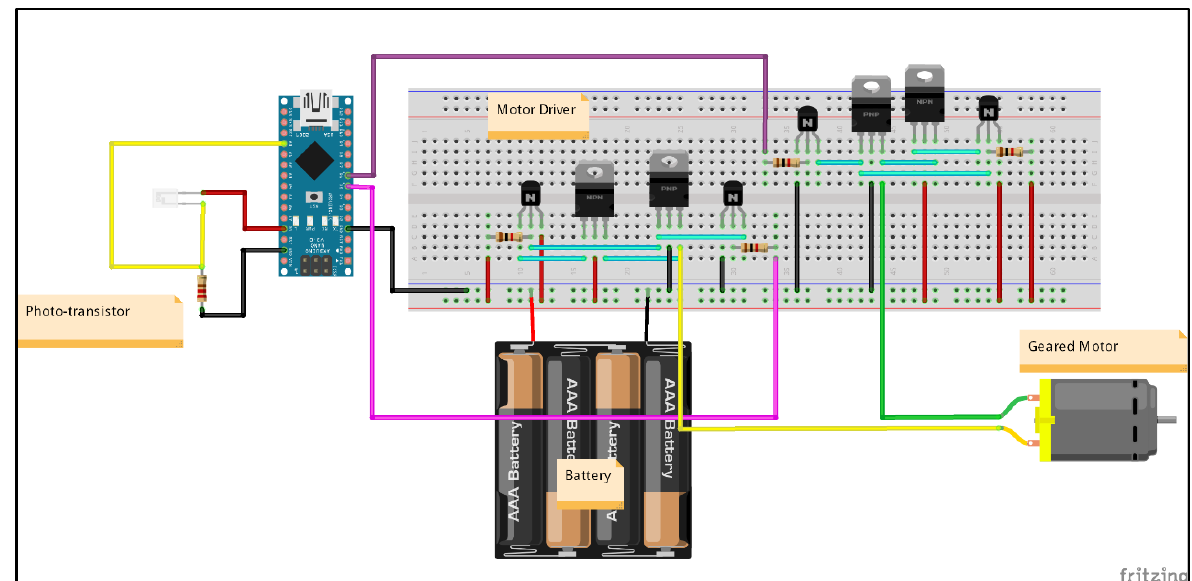
Figure 10. VLC tele-weight receiving end schematic diagram.